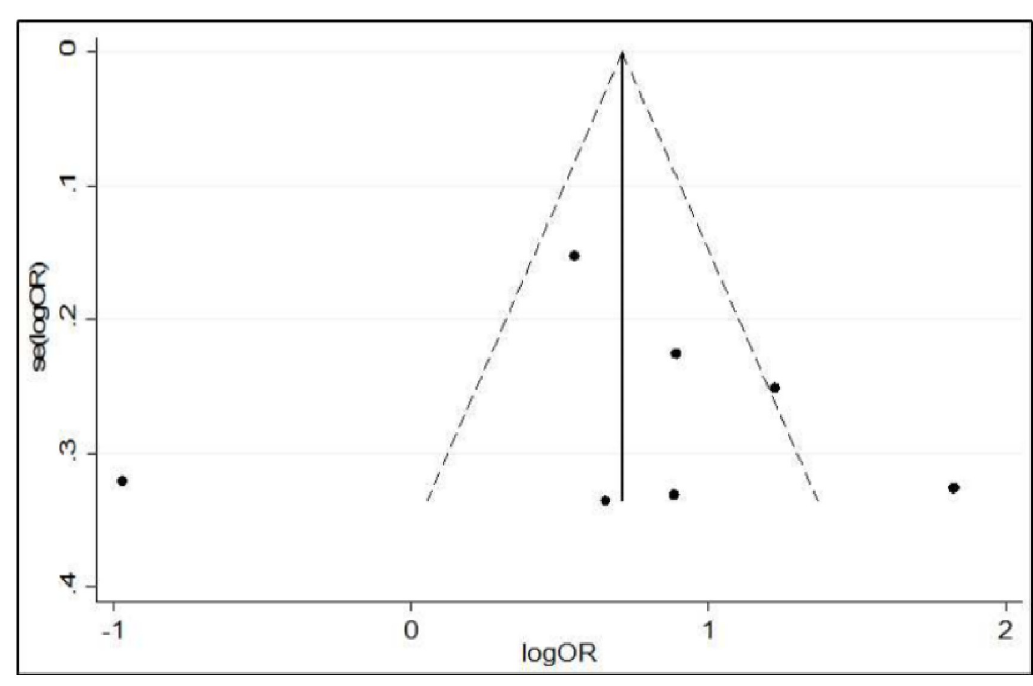
Fig 3. Funnel plot of publication bias.